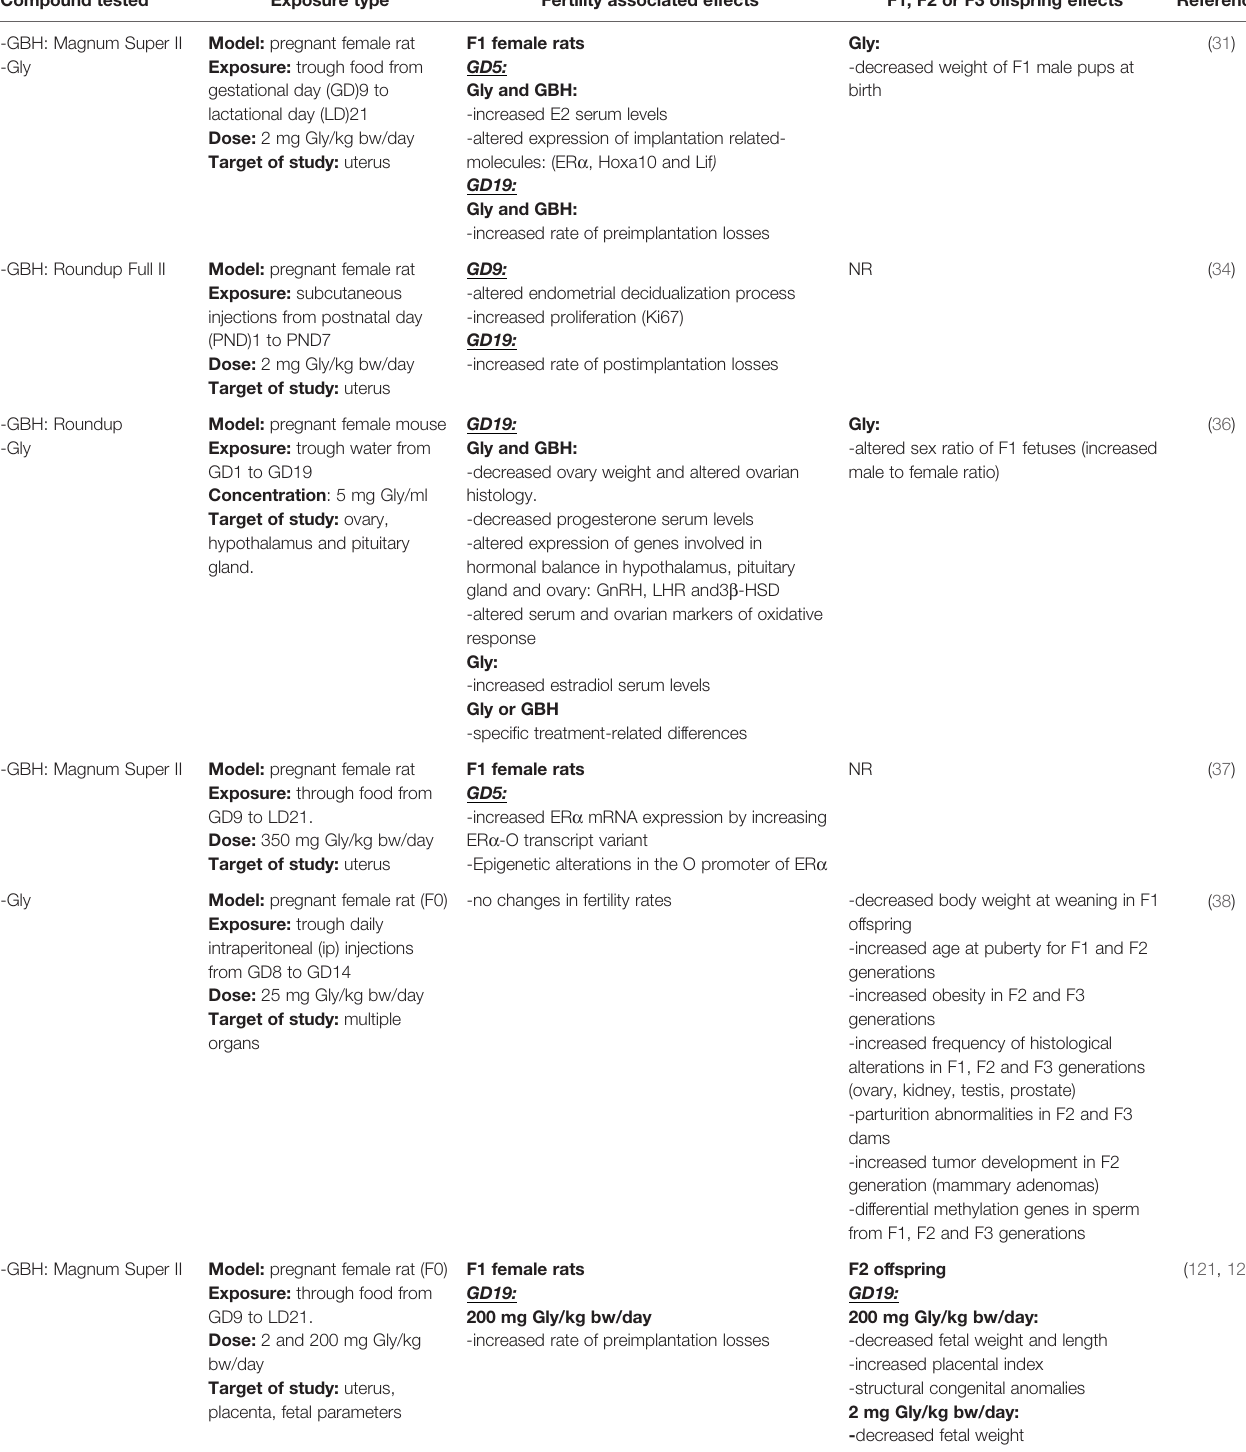
TABLE 4 | Effects of glyphosate (active ingredient) (Gly) and glyphosate-based herbicides (GBHs) associated with female fertility and those reported in the successive generations (F1, F2 or F3) of mammalian offspring after maternal exposure. Compound